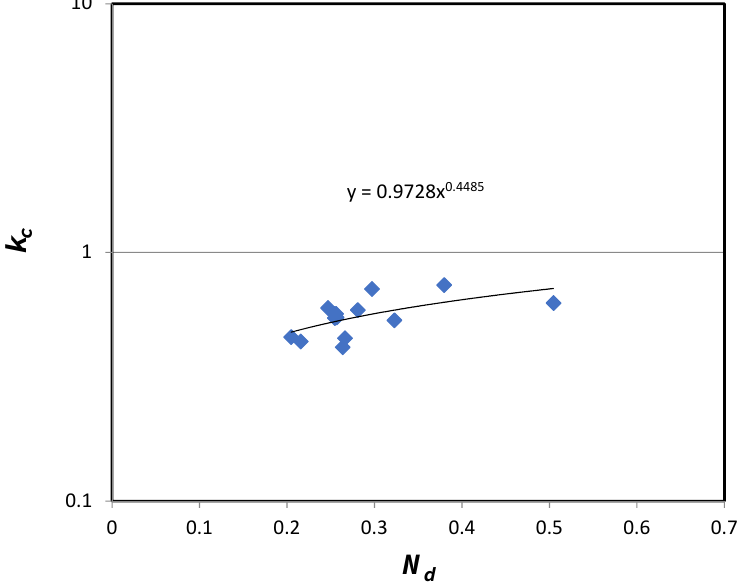
Figure 7. Plot of collection rate constant ( 𝑘 (cid:3030) ) versus vessel dispersion number ( N d ).